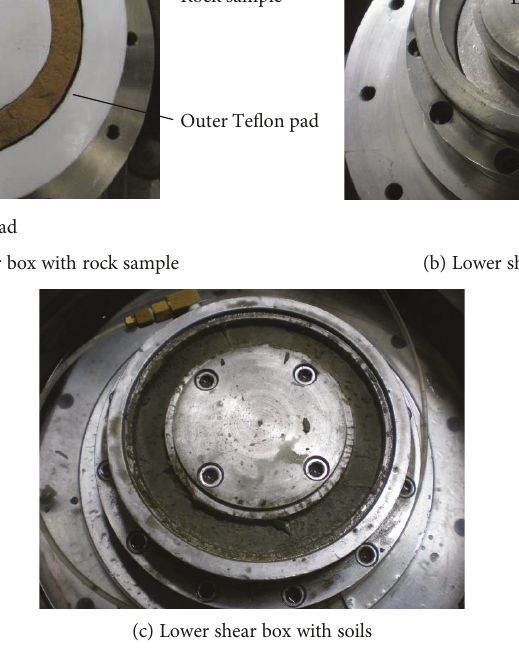
Figure 2: Ring shear